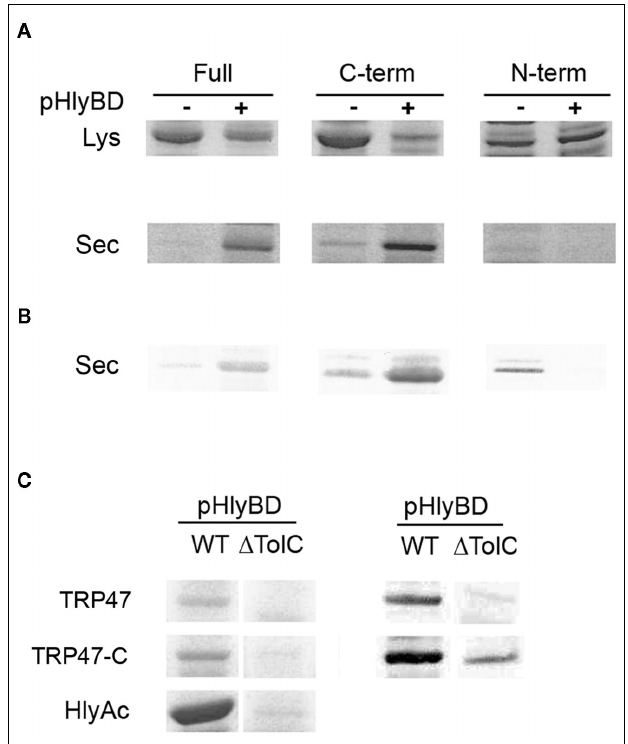
FIGURE 7 | Extracellular secretion of E. chaffeensis full length, C-terminal, and N-terminalTRP47 fragment from E. coli. (A,B) E. coli BW25113 cells containing pK184-HlyBD ( + ) or not containing pK184-HlyBD ( − ) and a plasmid encoding GST–TRP47 full length (Full), GST–TRP47 C-terminal (C-term), or GST–TRP47 N-terminal (N-term) fusion protein as indicated were grown in LB medium supplemented with 1.5mM IPTG to induce hlyBD coexpression and the production of the GST–TRP47 full length (Full), GST–TRP47 C-terminal (C-term), or GST–TRP47 N-terminal (N-term) fusion protein. Five hours after induction, protein in total cell extract [ (A) , Lys] or in theTCA-precipitated culture supernatants [ (A) , Sec] was analyzed by SDS-PAGE with Coomassie staining (A) or immunoblotting using anti-GST polyclonal antibodies [ (B) , Sec]. (C) E. coli BW25113 (WT) and CAG12184 ( Δ TolC) cells containing pK184-HlyBD and a plasmid encoding GST–TRP47 full length (TRP47), GST–TRP47 C-terminal (TRP47C), or HlyAc protein as indicated were cultured and protein expressed and purified as described above. For E. coli WT and Δ TolC cells containing plasmid encoding HlyAc at OD 660 = 0.8, the production of HlyAc protein was induced by the addition of arabinose to a final concentration of 10mM arabinose. Five hours after induction, protein in the culture supernatants wasTCA-precipitated and analyzed by SDS-PAGE with Coomassie staining [ (C) , left panel] or immunoblotting using anti-GST polyclonal antibodies [ (C) , right panel]. (Lys, indicates whole cell lysate; Sec, indicates secreted into the extracellular